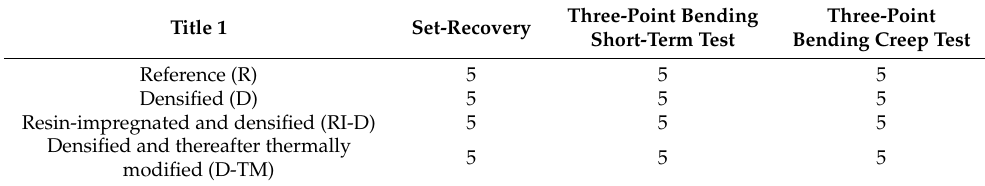
Table 1. Test groups and numbers of specimens in each group.